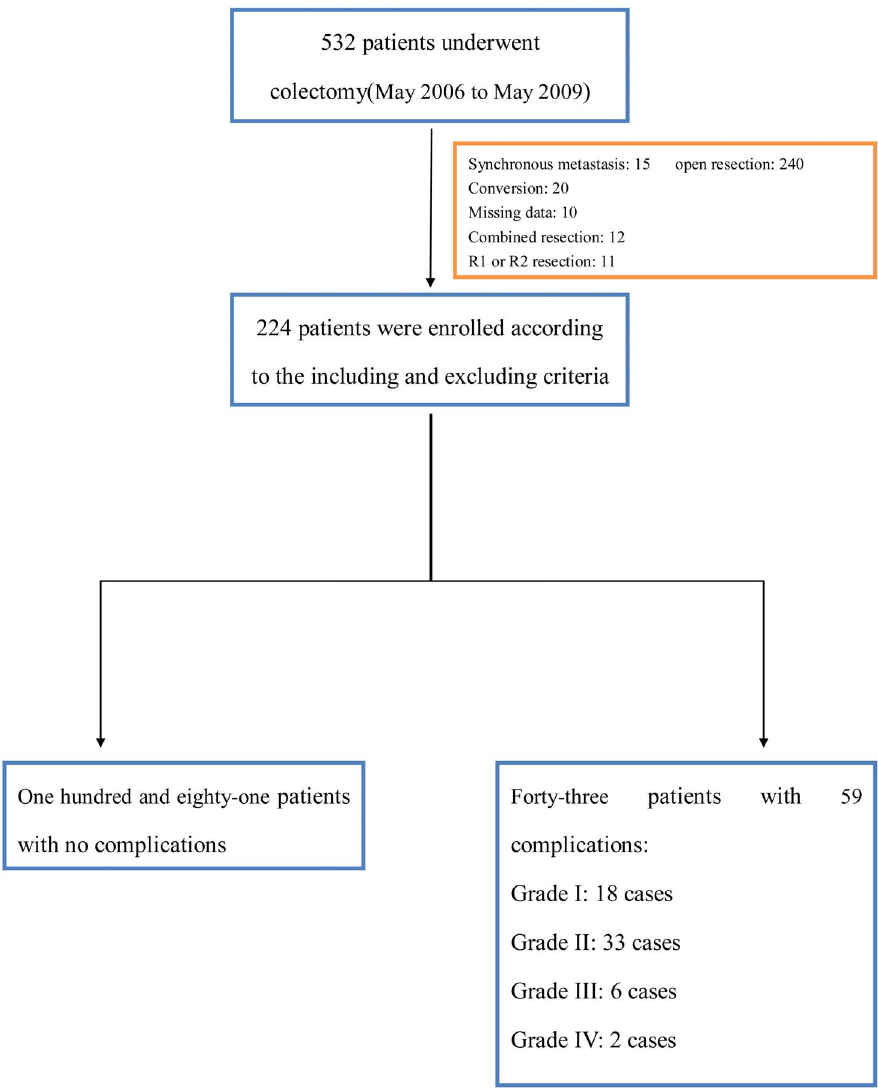
Figure 1. Study flow.